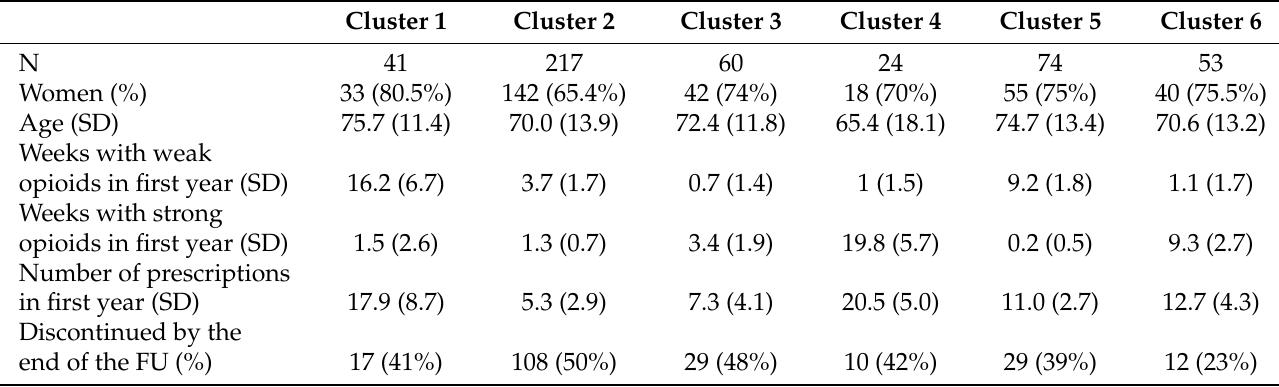
Table 3. Characteristics of the subjects by